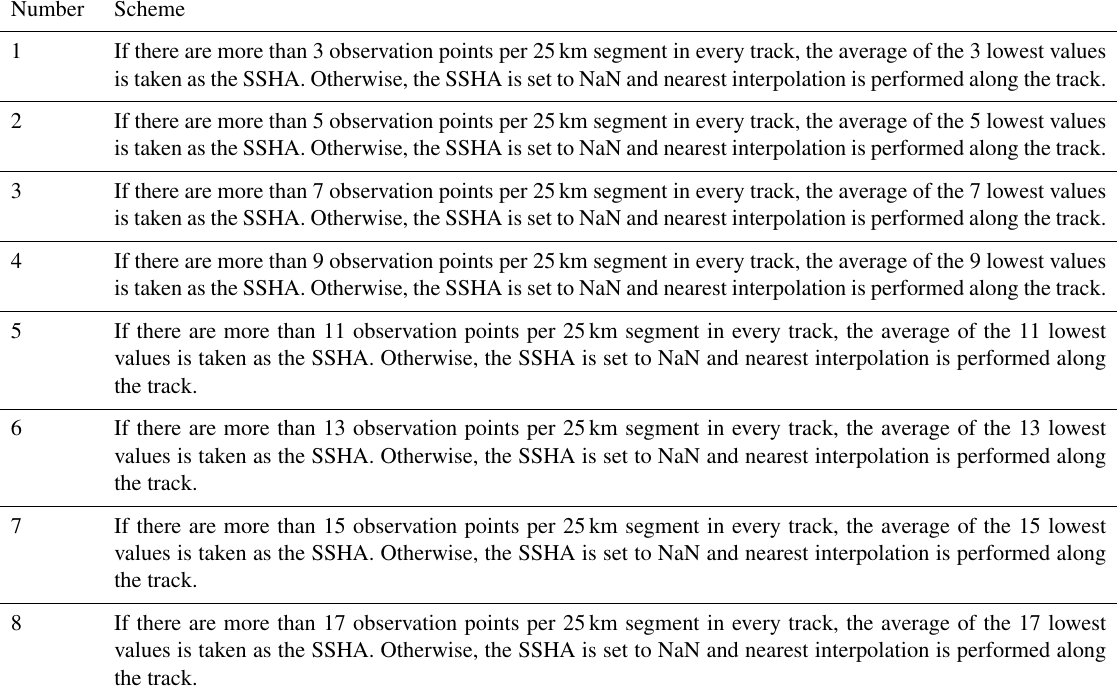
Table 7. Schemes for determining